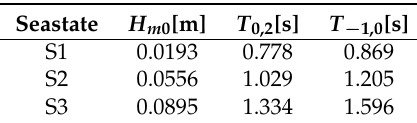
Table 4. Description of the realized irregular wave sea states in terms of wave height ( H m 0 ) and wave periods ( T 0,2 , T − 1,0 ), as measured in the basin without the